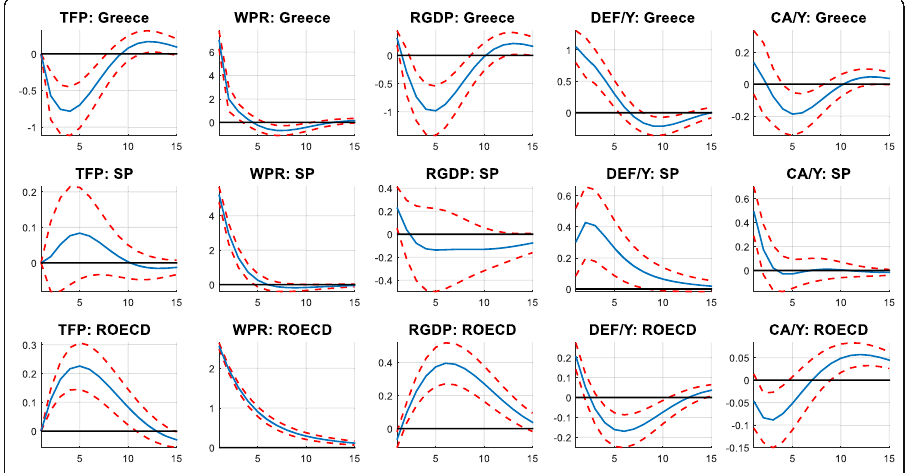
Fig. 5 Dynamic responses to a shock in the wage premium